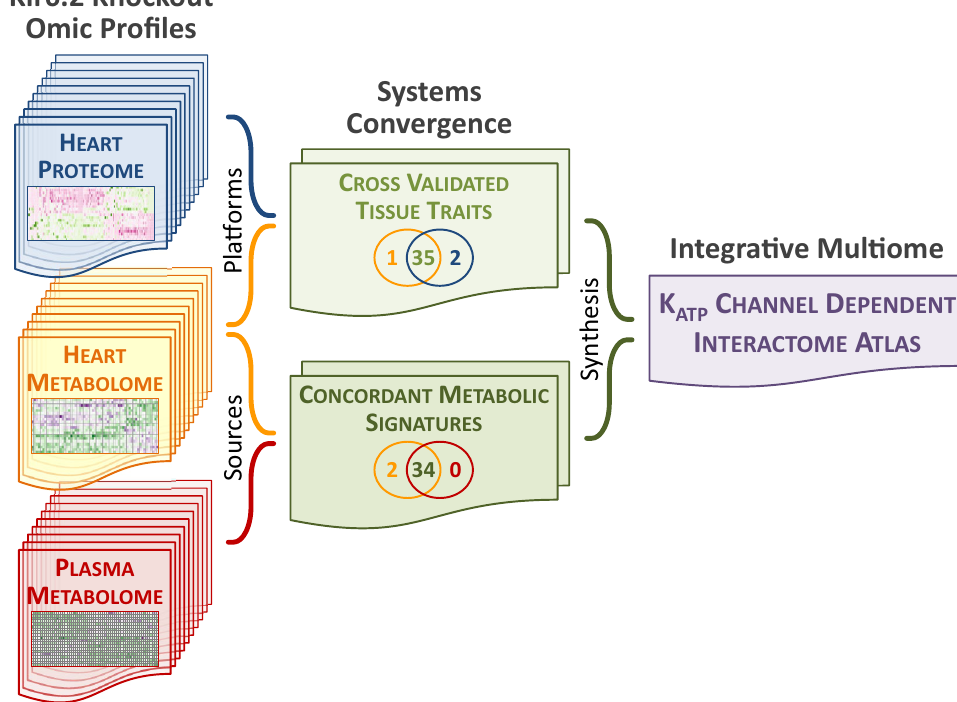
Figure 10. Mapping Kir6.2 dependent multiome atlas. The systems biology approach employed here resolved the Kir6.2 dependent interactome, underscoring the centrality of the intact K ATP channel in heart health. Applied steps included profiling of Kir6.2 knockout (left panels) with the heart proteome (see Figs. 1C, 2 and 3), the heart metabolome (see Figs. 4, 5, 6), and the plasma metabolome (see Fig. 8) sequentially delineated. Systems convergence of multiomics layers (middle panels) details cross-validation of heart proteome and metabolome functional traits (see Fig. 7), while concordant metabolomic signatures are evident between heart and plasma metabolomes (see Fig. 9). Taken together, omic profiles with systems convergence charted a comprehensive atlas of the K ATP channel dependent interactome (right